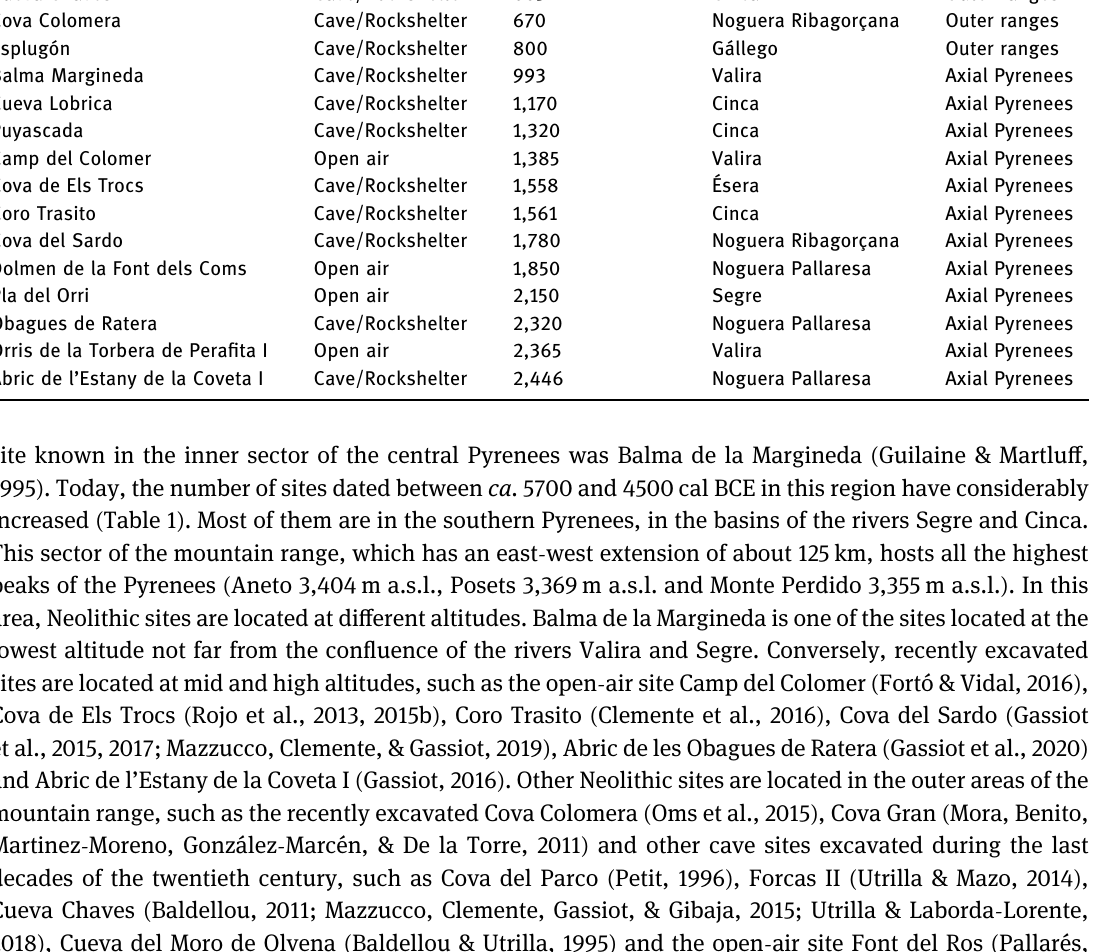
Table 1: Summary of sites mentioned in the text Site Type Altitude ( m a.s.l. ) Basin Location Cova Gran Cave/Rockshelter 385 Outer ranges Forcas II Cave/Rockshelter Outer ranges Cova del Parco Cave/Rockshelter Outer ranges Cueva del Moro de Olvena Cave/Rockshelter Outer ranges Font del Ros Open air Outer ranges Cueva Chaves Cave/Rockshelter 663 Outer ranges Cova Colomera Cave/Rockshelter 670 Outer ranges Esplugón Cave/Rockshelter Gállego Outer ranges Balma Margineda Cave/Rockshelter Cueva Lobrica Cave/Rockshelter Puyascada Cave/Rockshelter Camp del Colomer Open air Cova de Els Trocs Cave/Rockshelter Coro Trasito Cave/Rockshelter Cova del Sardo Cave/Rockshelter Dolmen de la Font dels Coms Open